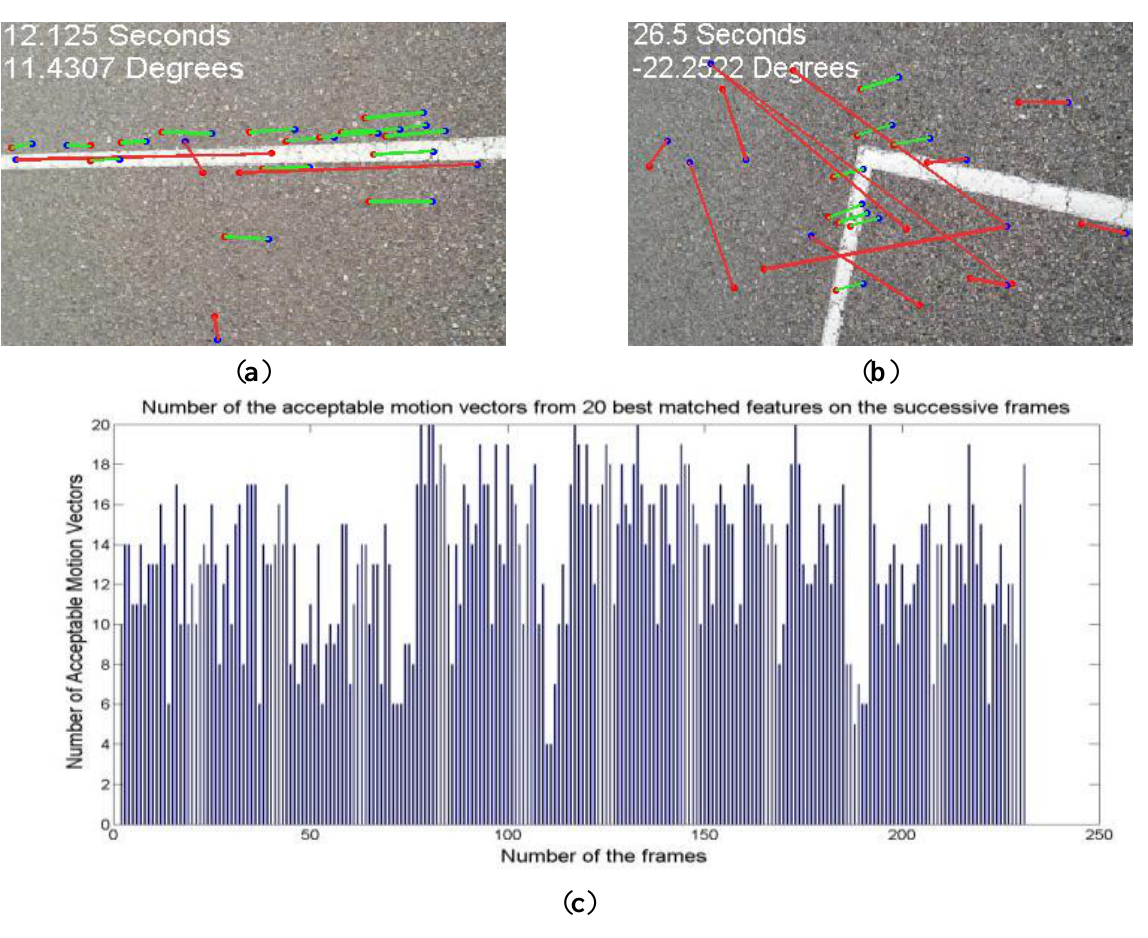
Figure 12. The matched features, candidate motion vectors (red), and accepted motion vectors (green) in two different cases: ( a ) forward motion and ( b ) change of the heading; ( c ) The number of the accepted motion vectors for two consecutive